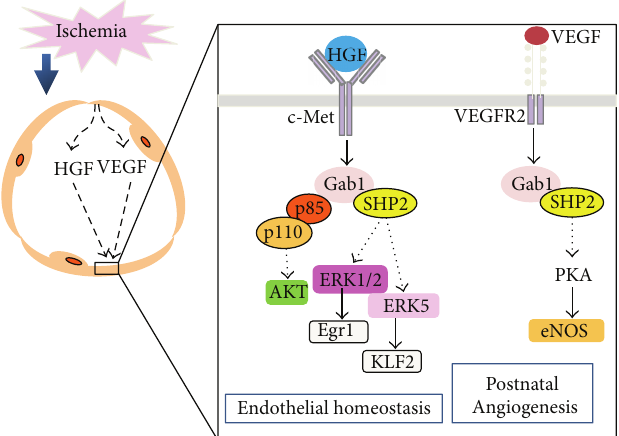
Figure 3: Schematic illustration of the role of Gab1 in postnatal angiogenesis and endothelial homeostasis. Hypoxic tissues secrete growth factors, such as HGF and VEGF, which stimulate their specific receptors on endothelial cells (inset). The activation of c-Met receptors leads to the tyrosine phosphorylation of Gab1 and thereby to the subsequent complex formation of Gab1 with both SHP2 and p85. Whereas the formation of the Gab1-SHP2 complex is required for the activation of ERK1/2 and ERK5, the Gab1-p85 complex is essential for the activation of AKT in response to HGF. The ERK1/2 and ERK5 pathways contribute to the upregulation of early growth response 1 (Egr1) and Kruppel-like factor 2 (KLF2). On the other hand, activation of the VEGFR2 receptors leads to the tyrosine phosphorylation of Gab1, and to the subsequent formation of the Gab1-SHP2 complex, which causes the activation of protein kinase A (PKA) and endothelial nitric oxide synthase (eNOS). Collectively, current findings indicate that Gab1 is an essential component of postnatal angiogenesis after